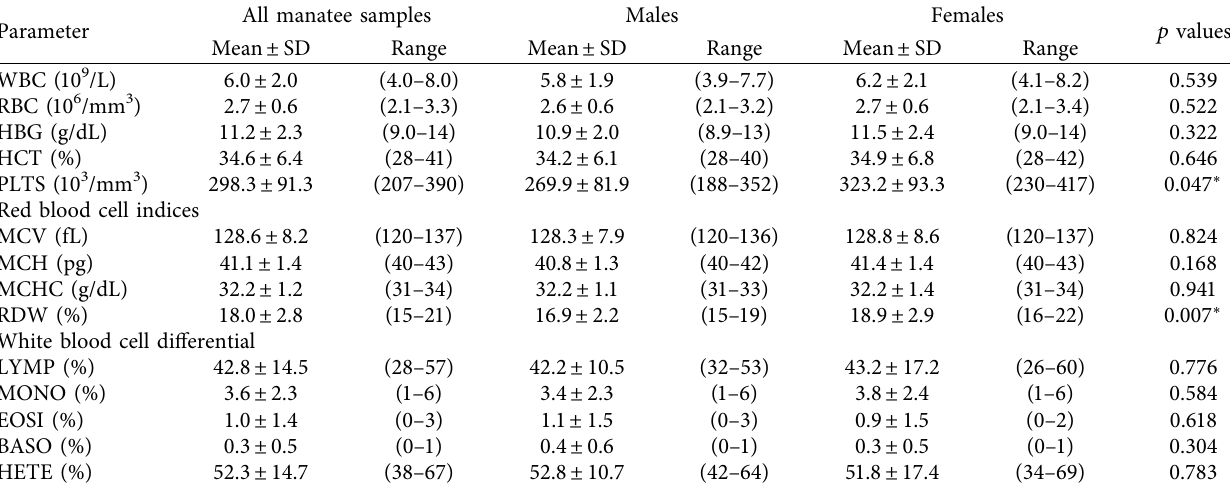
Table 3: Mean and standard deviation hematology values for Antillean manatees from Puerto Rico for all sex classes (males and females, n � 70): males only, n � 33, and females only, n � 37, with ± 1 standard deviation ranges in parentheses. Significant differences using p values are indicated with an asterisk ( ∗